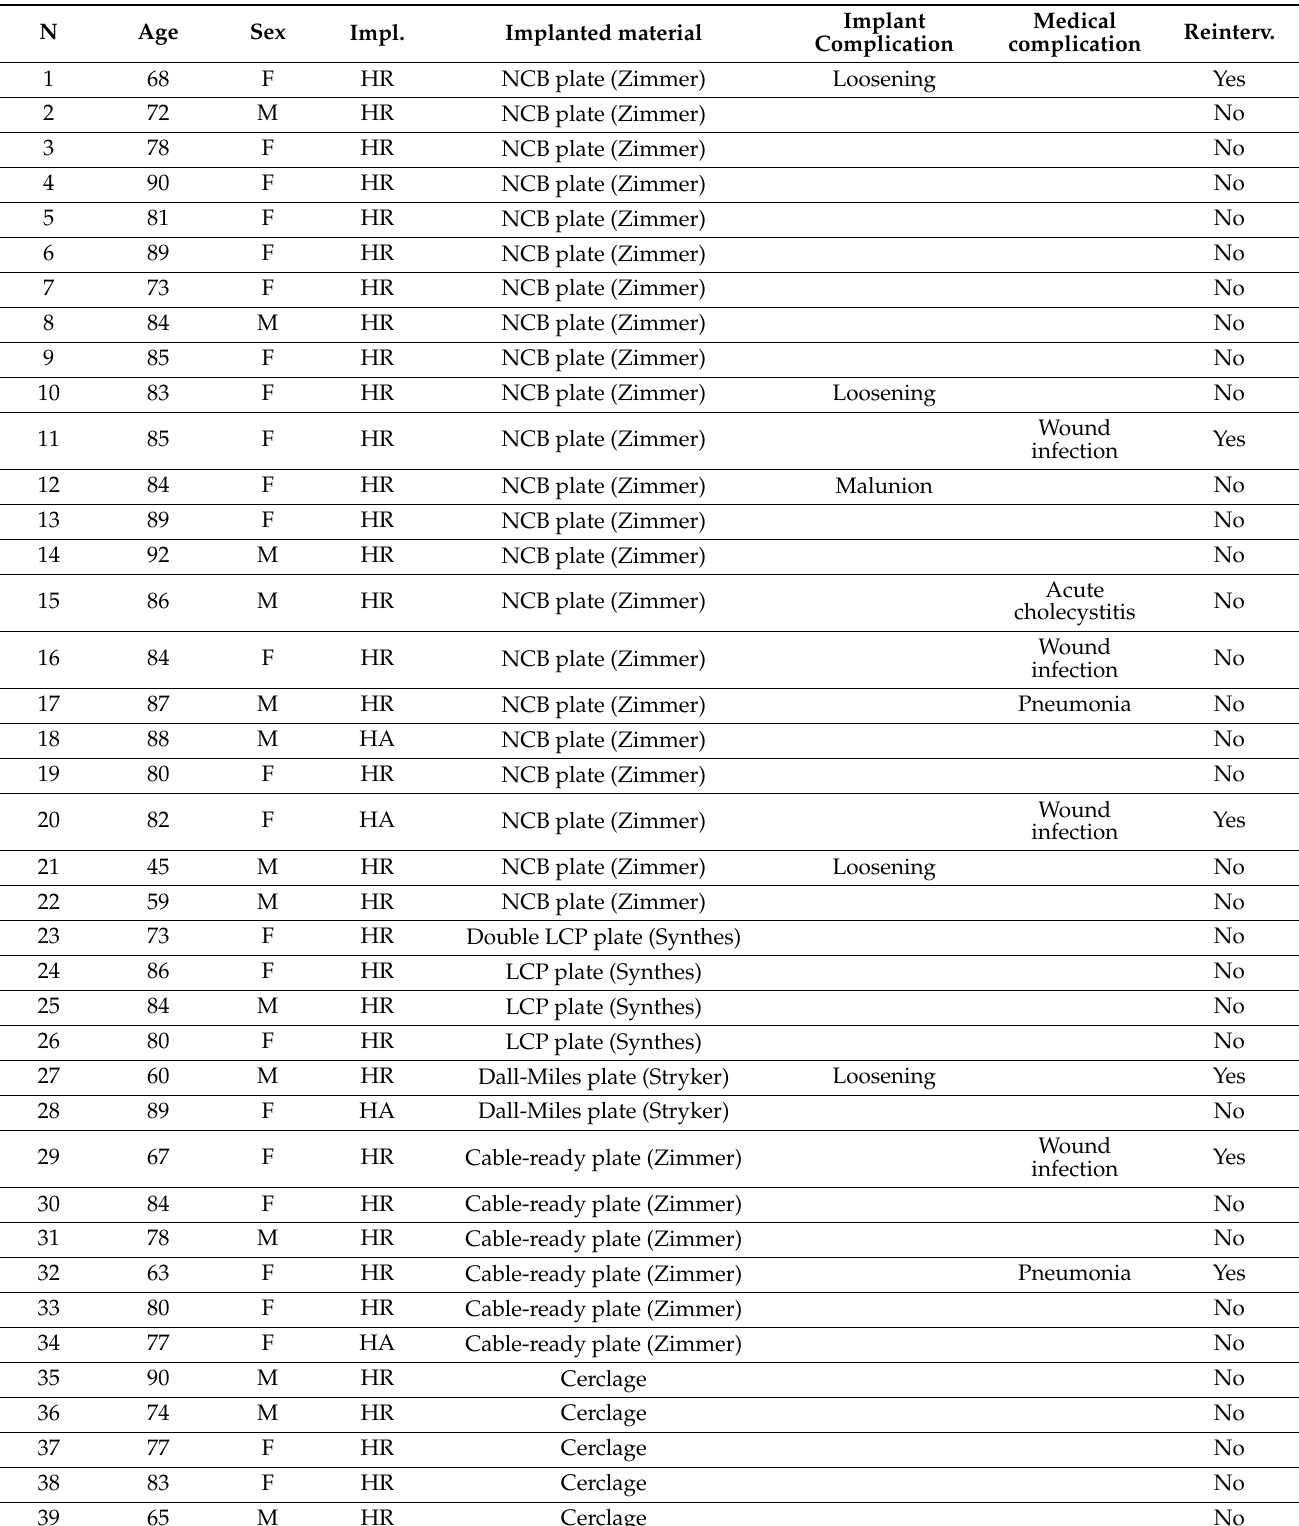
Table 2. Patients with Vancouver type B2 PPHF treated using osteosynthesis. (F = female, M = male, Impl. = Implant, HA = hemiarthroplasty, HR = hip replacement, Reinterv. = need for reintervention). N Age Sex Impl. Implanted material